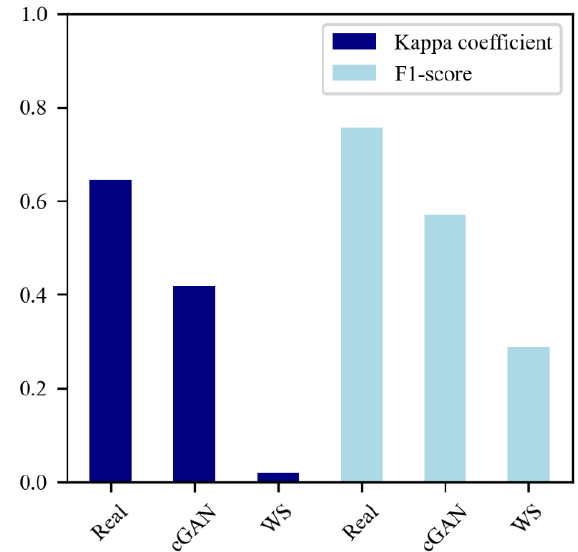
Figure 4. Metrics used for evaluation of the classification: Kappa coefficient and F 1